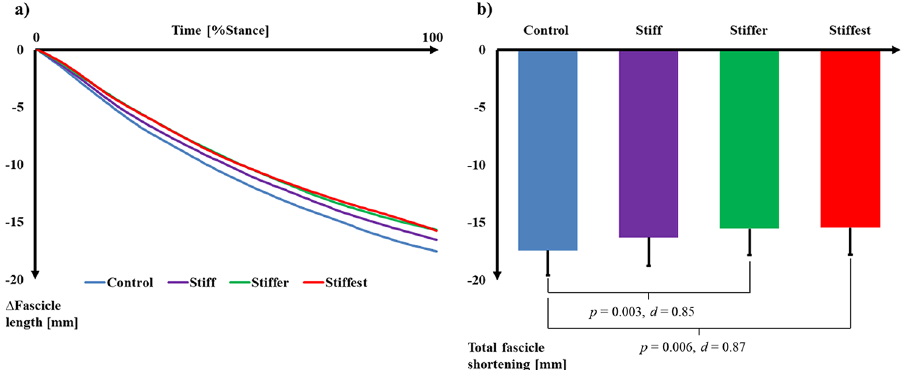
Figure 1. ( a ) Time-normalised, average (n = 14) change in gastrocnemius medialis muscle fascicle length over the stance phase of running relative to the length at heel-strike. ( b ) Average (± SD; n = 14) total gastrocnemius medialis fascicle shortening over the stance phase of running. p values and Cohen’s d effect sizes denote significant ( p ≤ 0.017) differences between conditions.